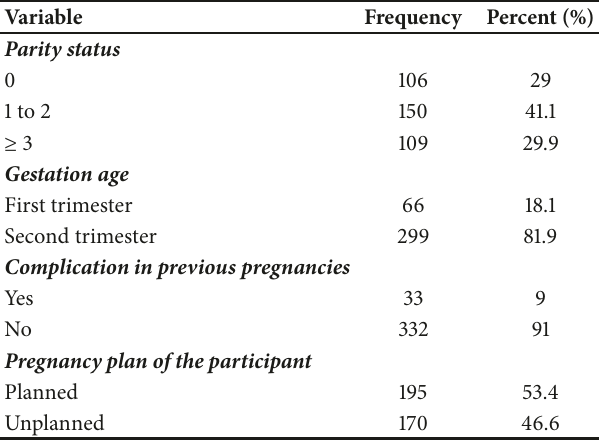
Table 2: Participants’ distribution by reproductive profile